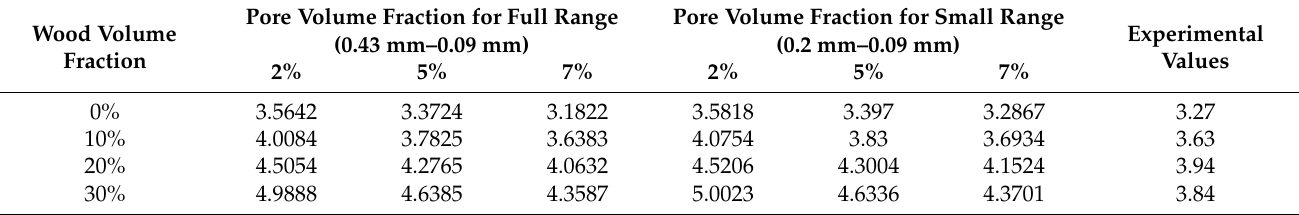
Table 2. Predicted Young’s modulus for the two-pore diameter